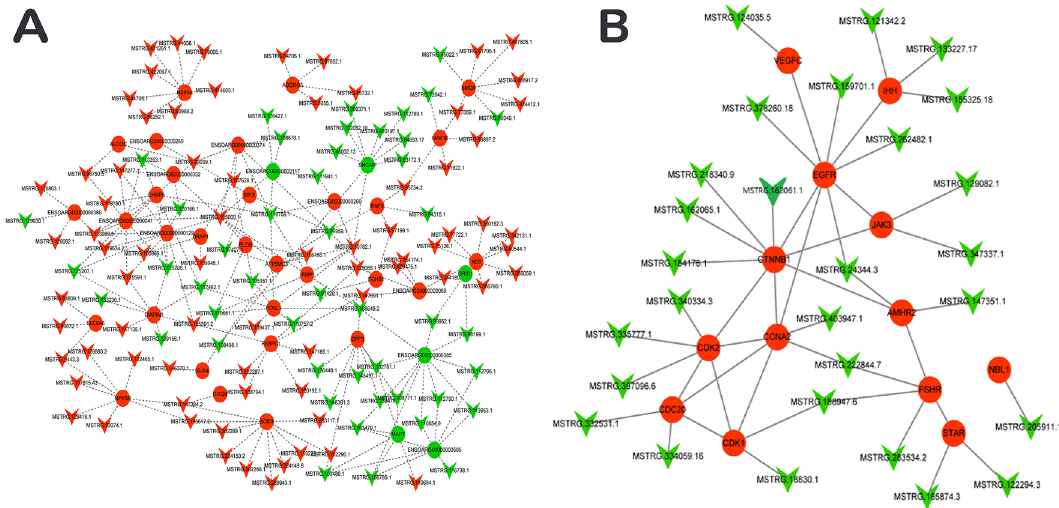
Figure 3. Co-expression network of the differentially expressed lncRNAs and mRNAs in ovary tissues in H1 vs H3 ( A ) H3 vs H8 ( B ). Triangle and circle nodes represent lncRNA and mRNAs, respectively. The nodes with red colour represent up-regulation, whereas those with green represents down-regulation. The dotted line represents the target relationship between two nodes.